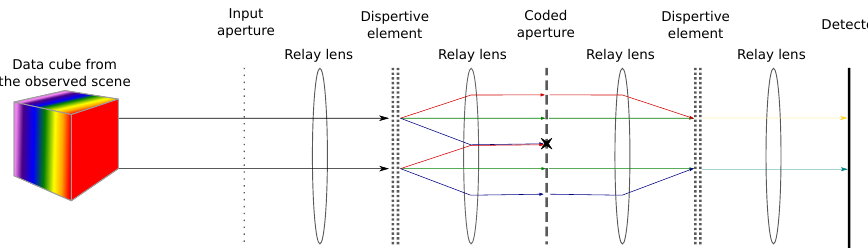
Figure 1. Principle of the DD CASSI system. Arrows represent the light rays that go through the system. Notice that because of the spectral multiplexing induced by the first dispersive element, light components from different light rays can be blocked by the same digit of the coded aperture. Hence, the figuratively yellow and indigo rays formed after the second dispersive element are missing some spectral